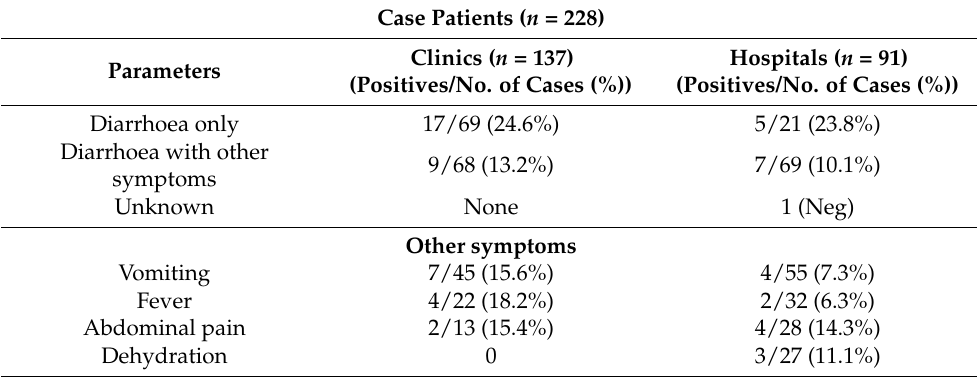
Table 3. Symptoms shown by children in Clinics versus Hospital